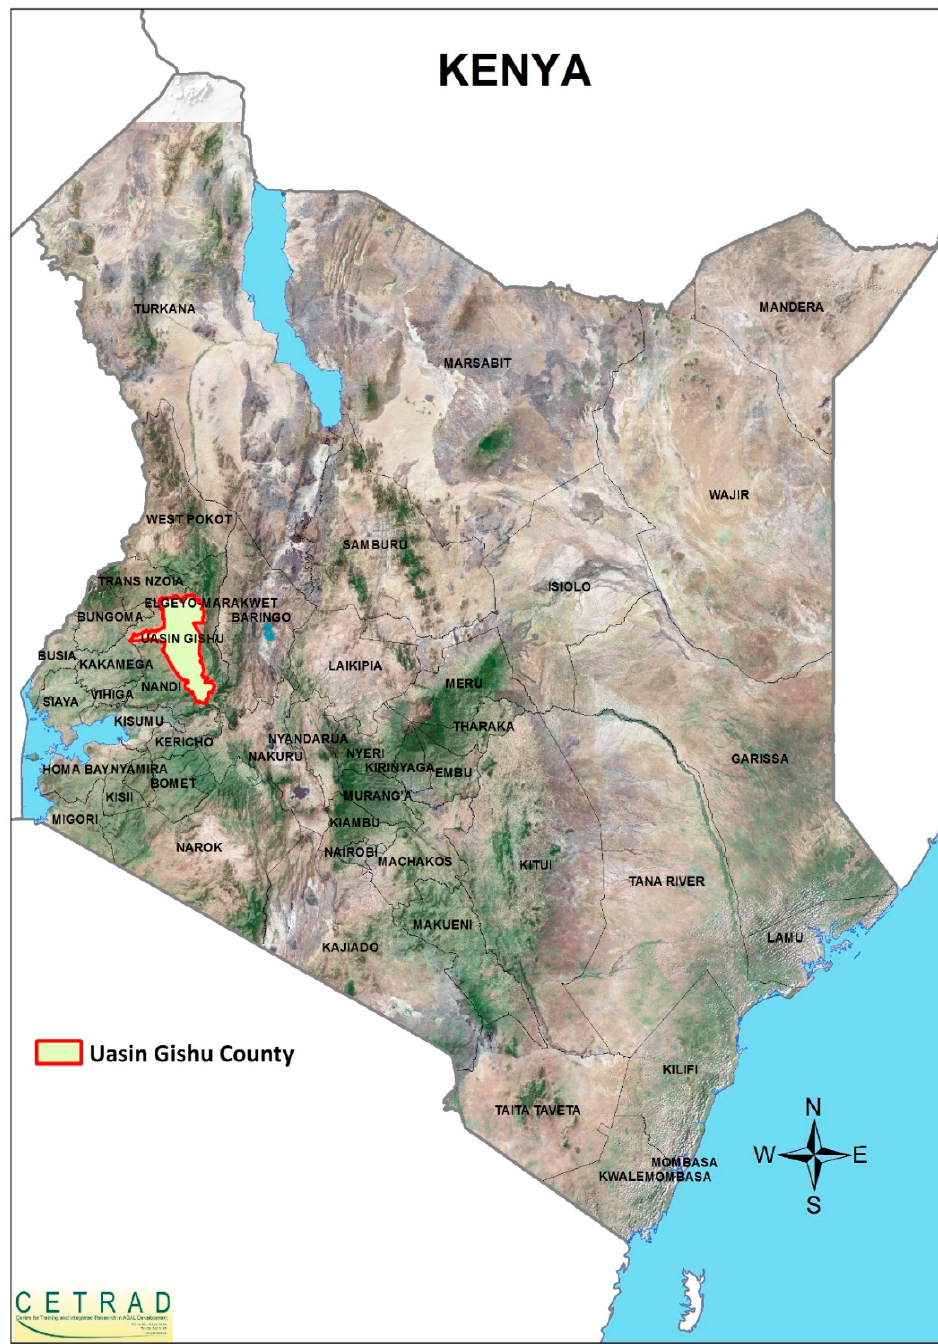
Figure 1. Study area is specifically Burnt Forest, situated in Uasin Gishu Figure1. Study area is specifically Burnt Forest, situated in Uasin Gishu County.